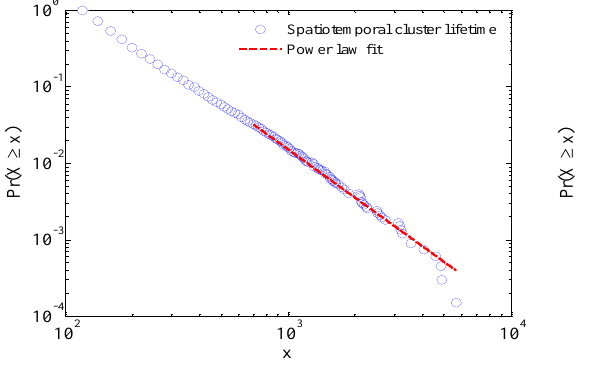
Figure 8. Power law distribution of lifetime and size of spatio-temporal